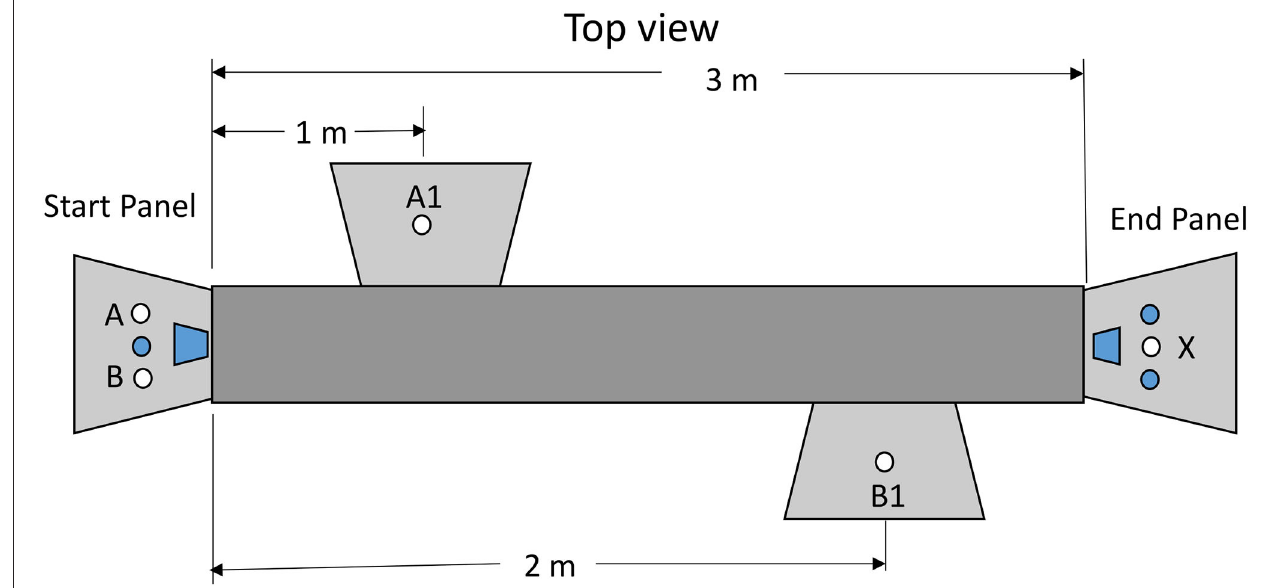
FIGURE 9 | Apparatus used in the Zentall et al. (2020, Experiment 1). Pigeons made a choice between stimulus lights A and B. If they chose A, they would have to peck A1 10 times and then peck stimulus X for reinforcement. If they chose B, they would have to peck B1 10 times and then peck stimulus X for reinforcement.